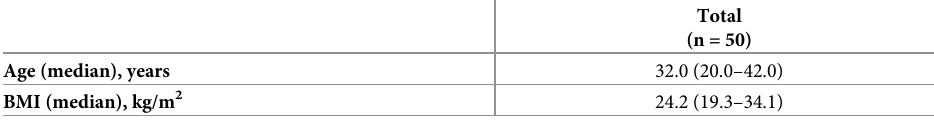
Table 1. Demographic data of the women included in this study.